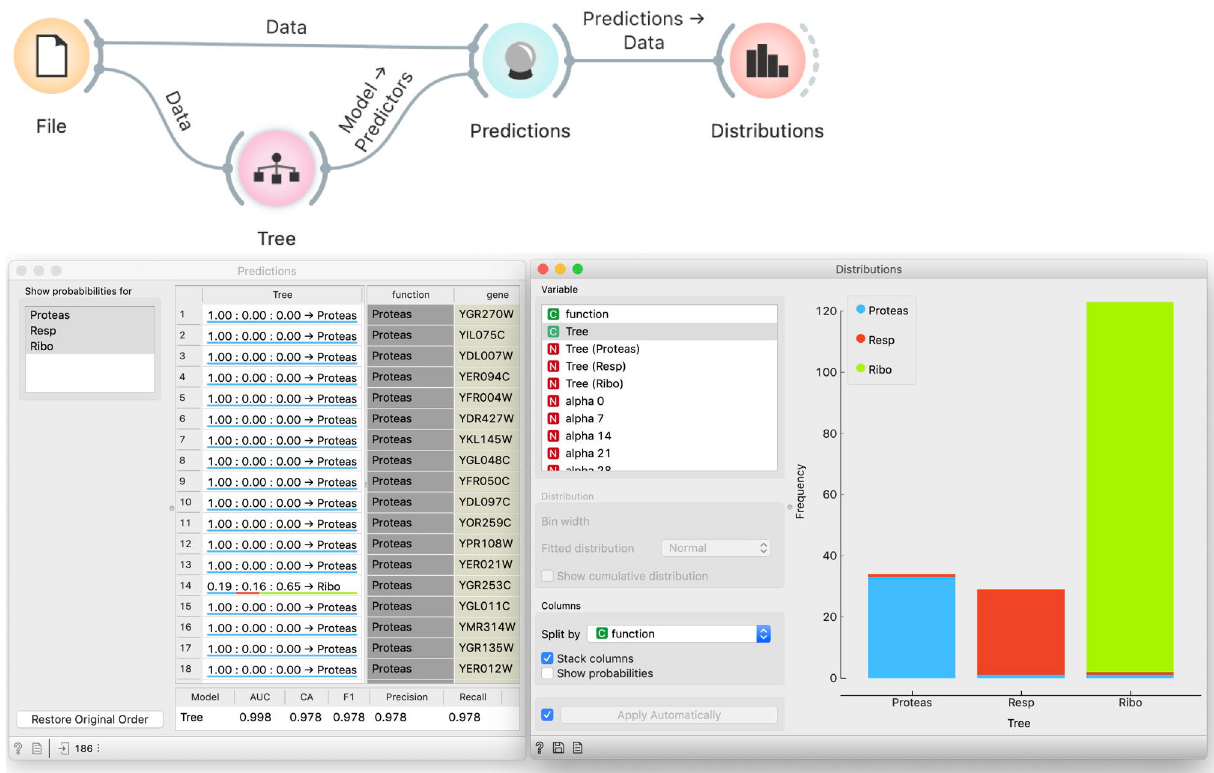
Fig 2. Incorrect evaluation of models. The tree is tested on the data from which it was induced. The Distribution widget shows perfect correspondence between the predicted and actual gene functions.